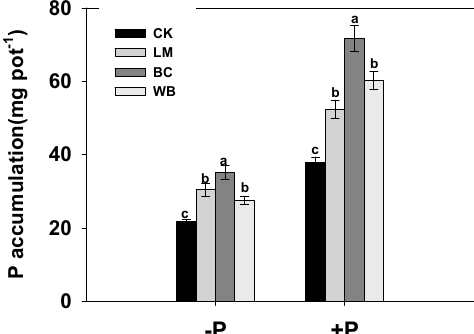
Figure 1. Effect of biochar and P supply on P accumulation in rice shoots. Each value is the mean ± standard error of four replicates. Different letters indicate means that differ significantly ( p < 0.05). The treatments were: CK: the control treatment; LM: lime equivalent to a biochar application rate of 20 g kg − 1 ; BC: biochar at an application rate of 20 g kg − 1 ; WBC: washed biochar at an application rate of 20 g kg − 1 .